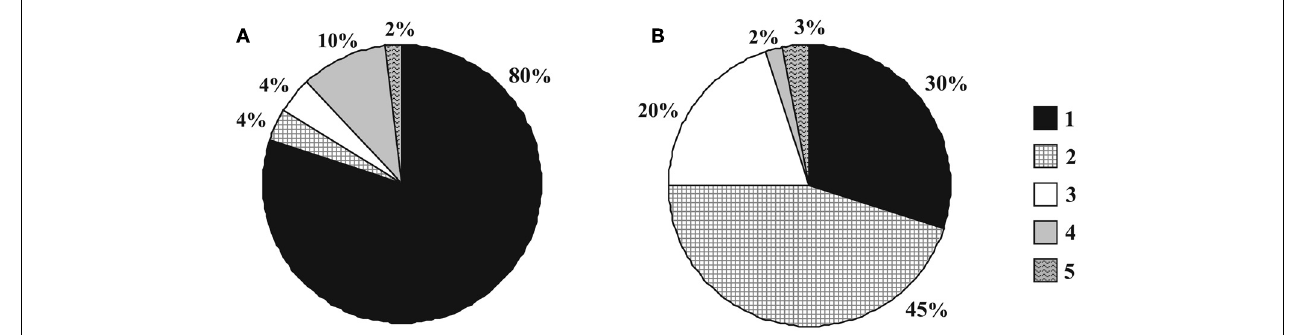
FIGURE 6 | Community structure of planctomycetes in oxic (A) versus anoxic (B) peat: 1 – Isosphaera – Singulisphaera group, 2 – Zavarzinella -like planctomycetes, 3 – Pirellula -like planctomycetes, 4 – Schlesneria spp., 5 – others.